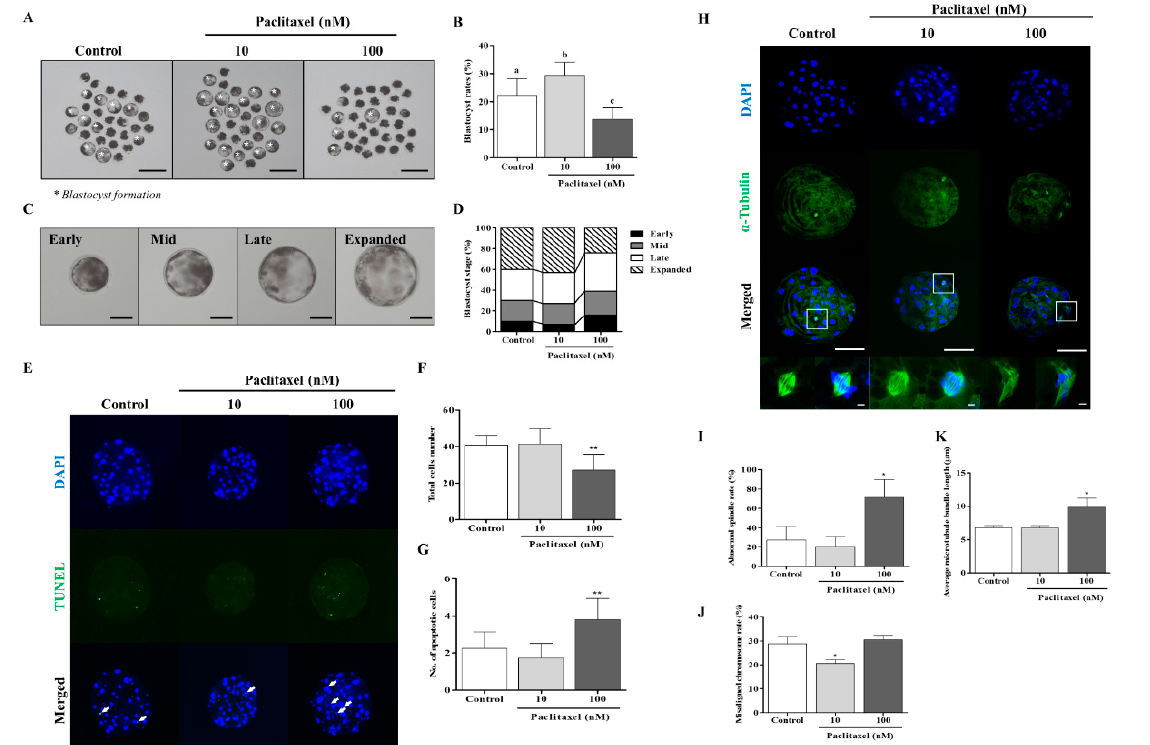
Figure 3. Effects of paclitaxel exposure on blastocyst developmental competence and quality in por- cine embryos. ( A , B ) Representative photographs and total blastocyst formation number (white as- terisks) by 10 and 100 nM paclitaxel exposure on porcine embryo development. Scale bar = 150 μ m. ( C , D ) Percentage of blastocyst developmental rate as Early, Mid, Late, and Expanded stage after 10 and 100 nM paclitaxel treatment in porcine embryos. Data represent at least three independent ex- periments and are shown as means ± SD. Different superscript letters denote a significant difference ( p < 0.05). ( E – G ) Detection of apoptotic cells and total nuclei in 10 and 100 nM paclitaxel exposed blastocysts using TUNEL (green, white arrow) and DAPI (blue) staining. The graphs show the num- ber of total nuclei and apoptotic embryo rates in blastocysts treated with 10 and 100 nM paclitaxel. Scale bar = 50 μ m. ( H – K ) Fluorescence expression of α -tubulin formation related to spindle assembly and chromosome alignment in developed porcine blastocyst after 10 and 100 nM paclitaxel treat- ment ( α -tubulin: green and DAPI: blue). Data are expressed as mean ± SD and were analyzed using one-way ANOVA followed by Tukey’s multiple comparison test. Differences were considered sig- nificant at * p < 0.05 and ** p < 0.01. Table 3. Percentage of fertilization and blastocyst formation after paclitaxel treatment. Paclitaxel (nM)